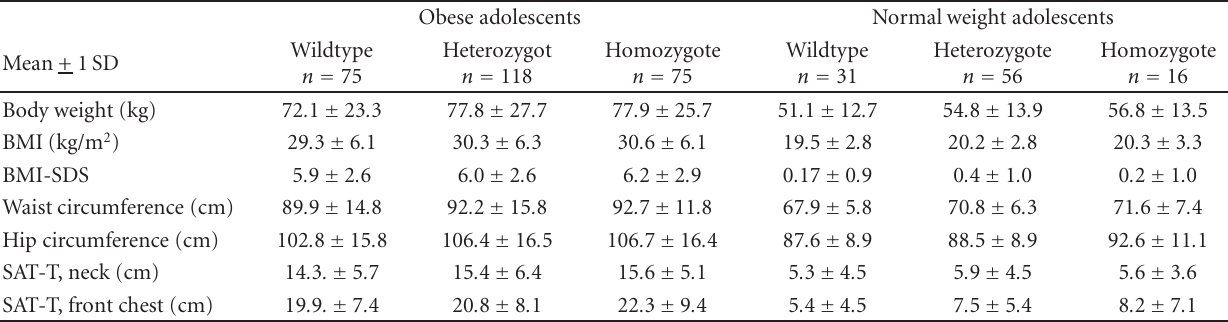
Table 4: Clinical parameters and the rs9939609 FTO gene polymorphism within all experimental